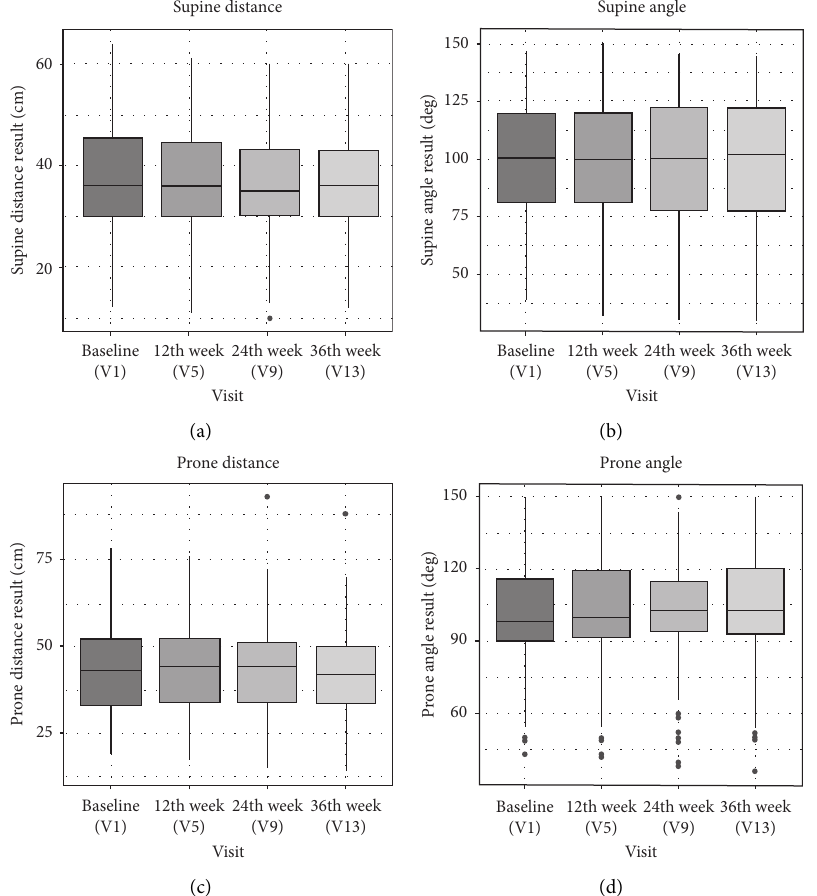
Figure 3: Results of heel-thigh distance flexion test. Comparison of supine distance, supine angle, prone distance, and prone angle at visit 1, visit 5 (after 12 weeks), visit 9 (after 24 weeks), and visit 13 (after 36